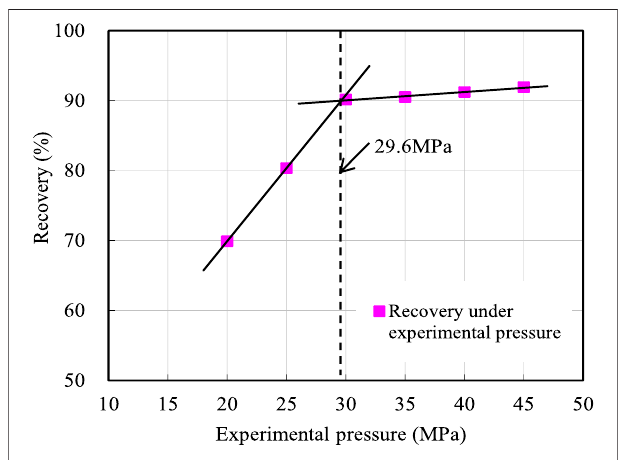
FIGURE 3 | The relation curve of recovery ratio and experimental